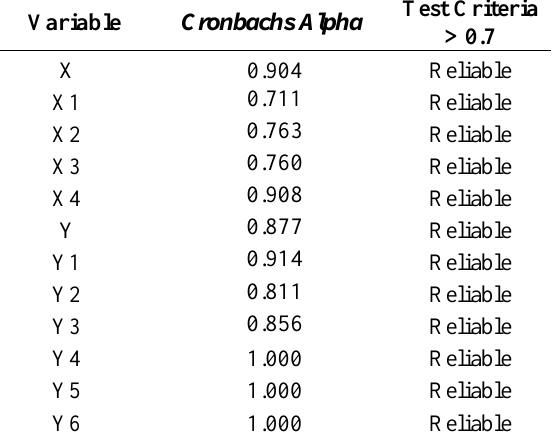
Table 7 Cronbachs Alpha Test